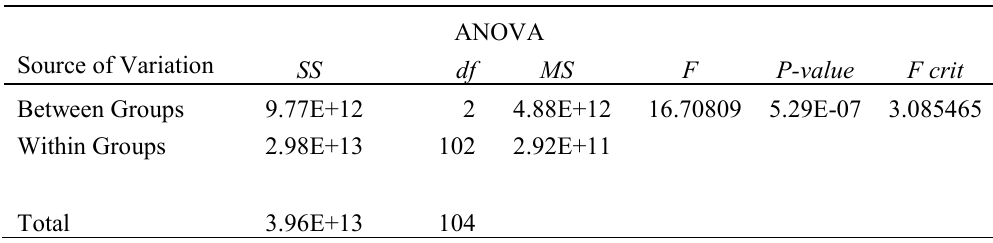
Table 4. Analysis of Variance in Rental Values of Commercial Complexes in the Study Area ANOVA Source of Variation SS df MS F P-value F crit Between Groups 9.77E+12 Within Groups